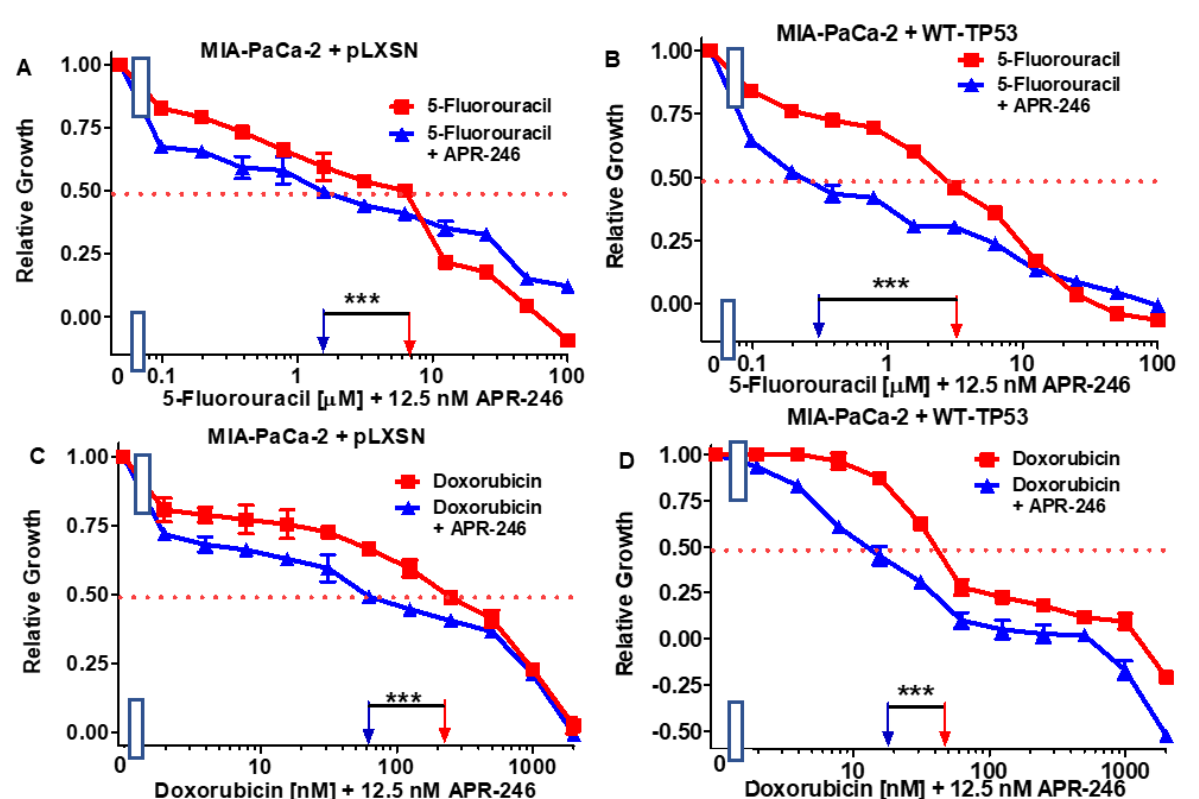
Figure 4. Effects of combining a low concentration of 12.5 nM APR-246 on the IC 50 values of 5FU and doxorubicin in MIA-PaCa-2 + pLXSN and MIA-PaCa-2 + WT-TP53 Cells. Panel ( A ) MIA-PaCa- 2 + pLXSN cells treated with different concentrations of 5FU (red squares) and MIA-PaCa-2 + pLXSN cells treated with different concentrations of 5FU and a low dose of 12.5 nM APR-246 (blue triangles). Panel ( B ) MIA-PaCa-2 + WT-TP53 cells treated with different concentration of 5FU (red squares) and MIA-PaCa-2 + WT-TP53 cells treated with different concentrations of 5FU and a low dose of 12.5 nM APR-246 (blue triangles). Panel ( C ) MIA-PaCa-2 + pLXSN cells treated with different concentrations of doxorubicin (red squares) and MIA-PaCa-2 + pLXSN cells treated with different concentrations of doxorubicin and a low dose of 12.5 nM APR-246 (blue triangles). Panel ( D ) MIA-PaCa-2 + WT-TP53 cells treated with different concentration of doxorubicin (red squares) and MIA-PaCa-2 + WT-TP53 cells treated with different concentrations of doxorubicin and a low dose of 12.5 nM APR-246 (blue triangles). *** = p <0.0001.